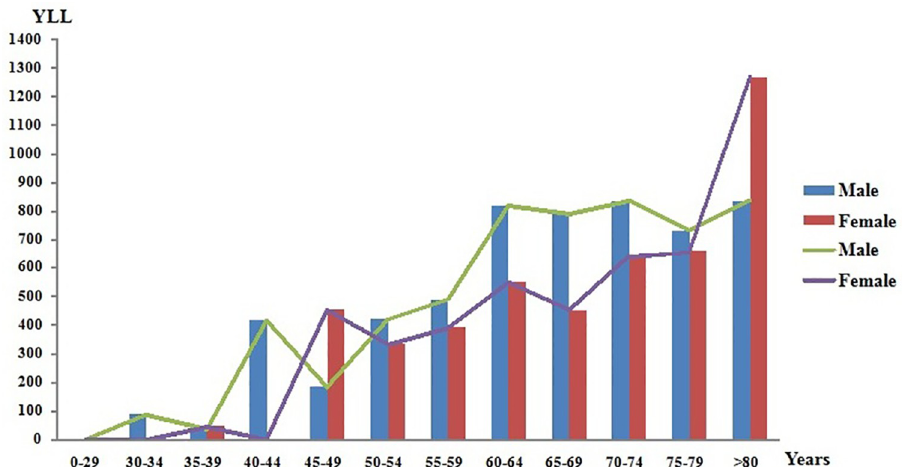
Fig 2. The gender and age stratification on the absolute value of YLLs. The columns indicate the number of YLLs; the lines show the tendency of YLLs at different age groups.